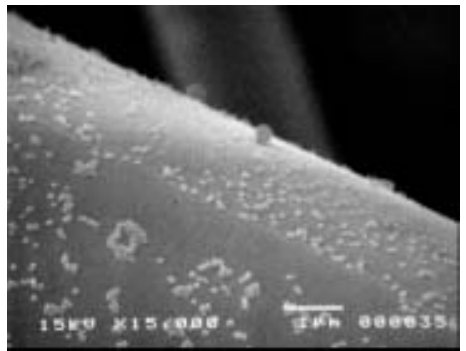
Fig. 5 Scanning electron microscopic images of silica particles deposited on FS surface.